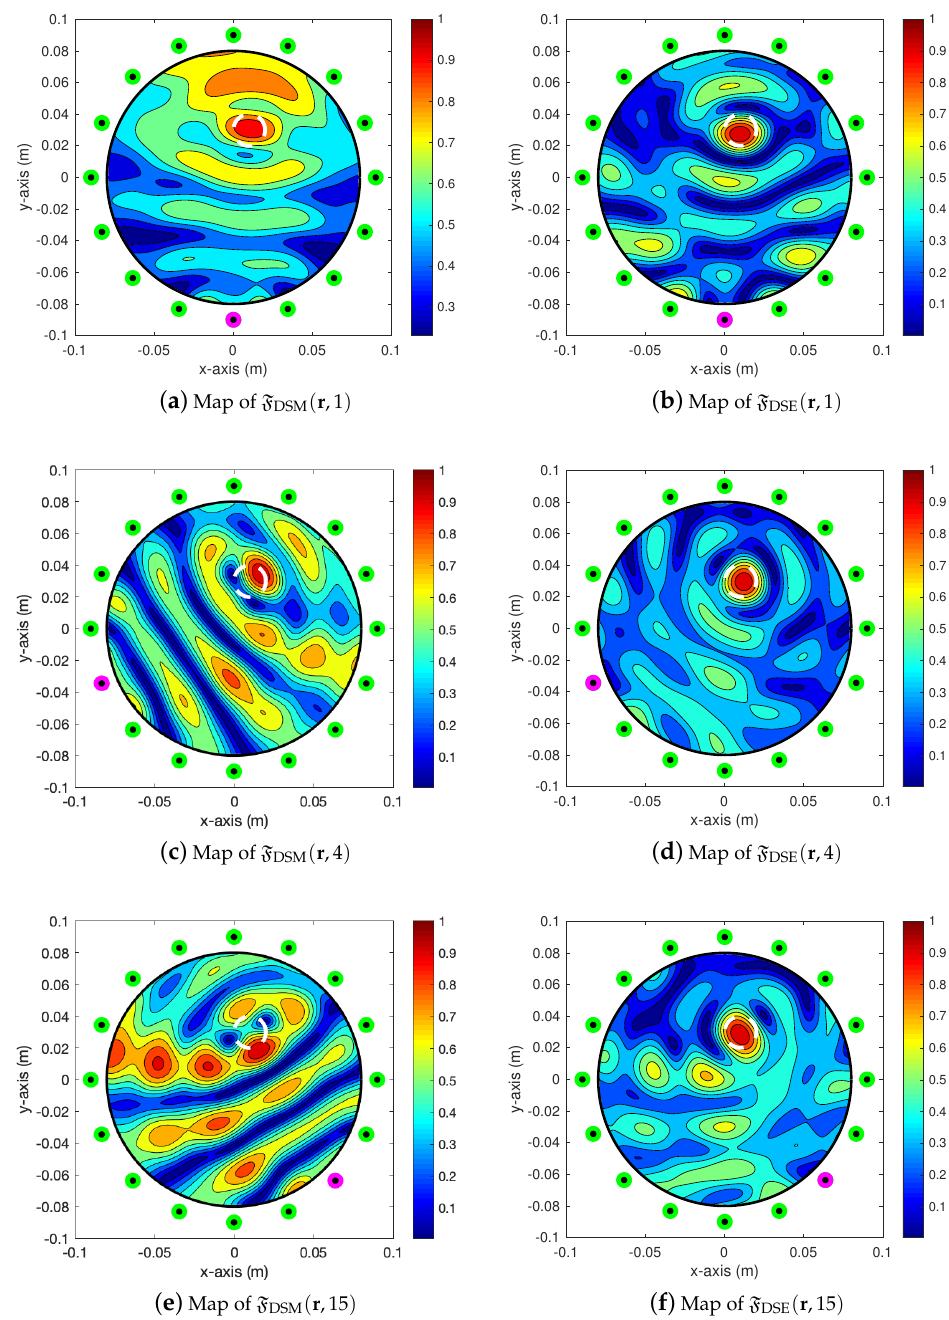
Figure 3. Maps of F DSM ( r , m ) and F DSE ( r , m ) at f = 1.245GHz. White-colored dashed line describes the ∂ D